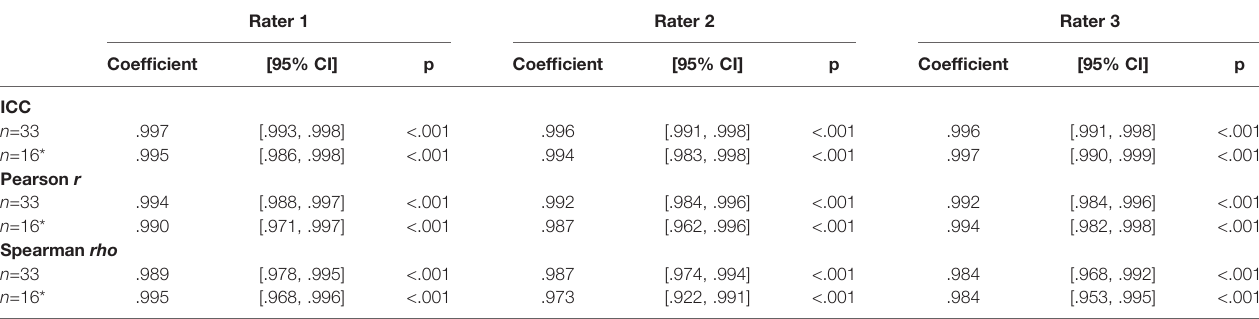
TABLE 2 | Pearson correlation coef fi cients among the parameters measured in the present study.